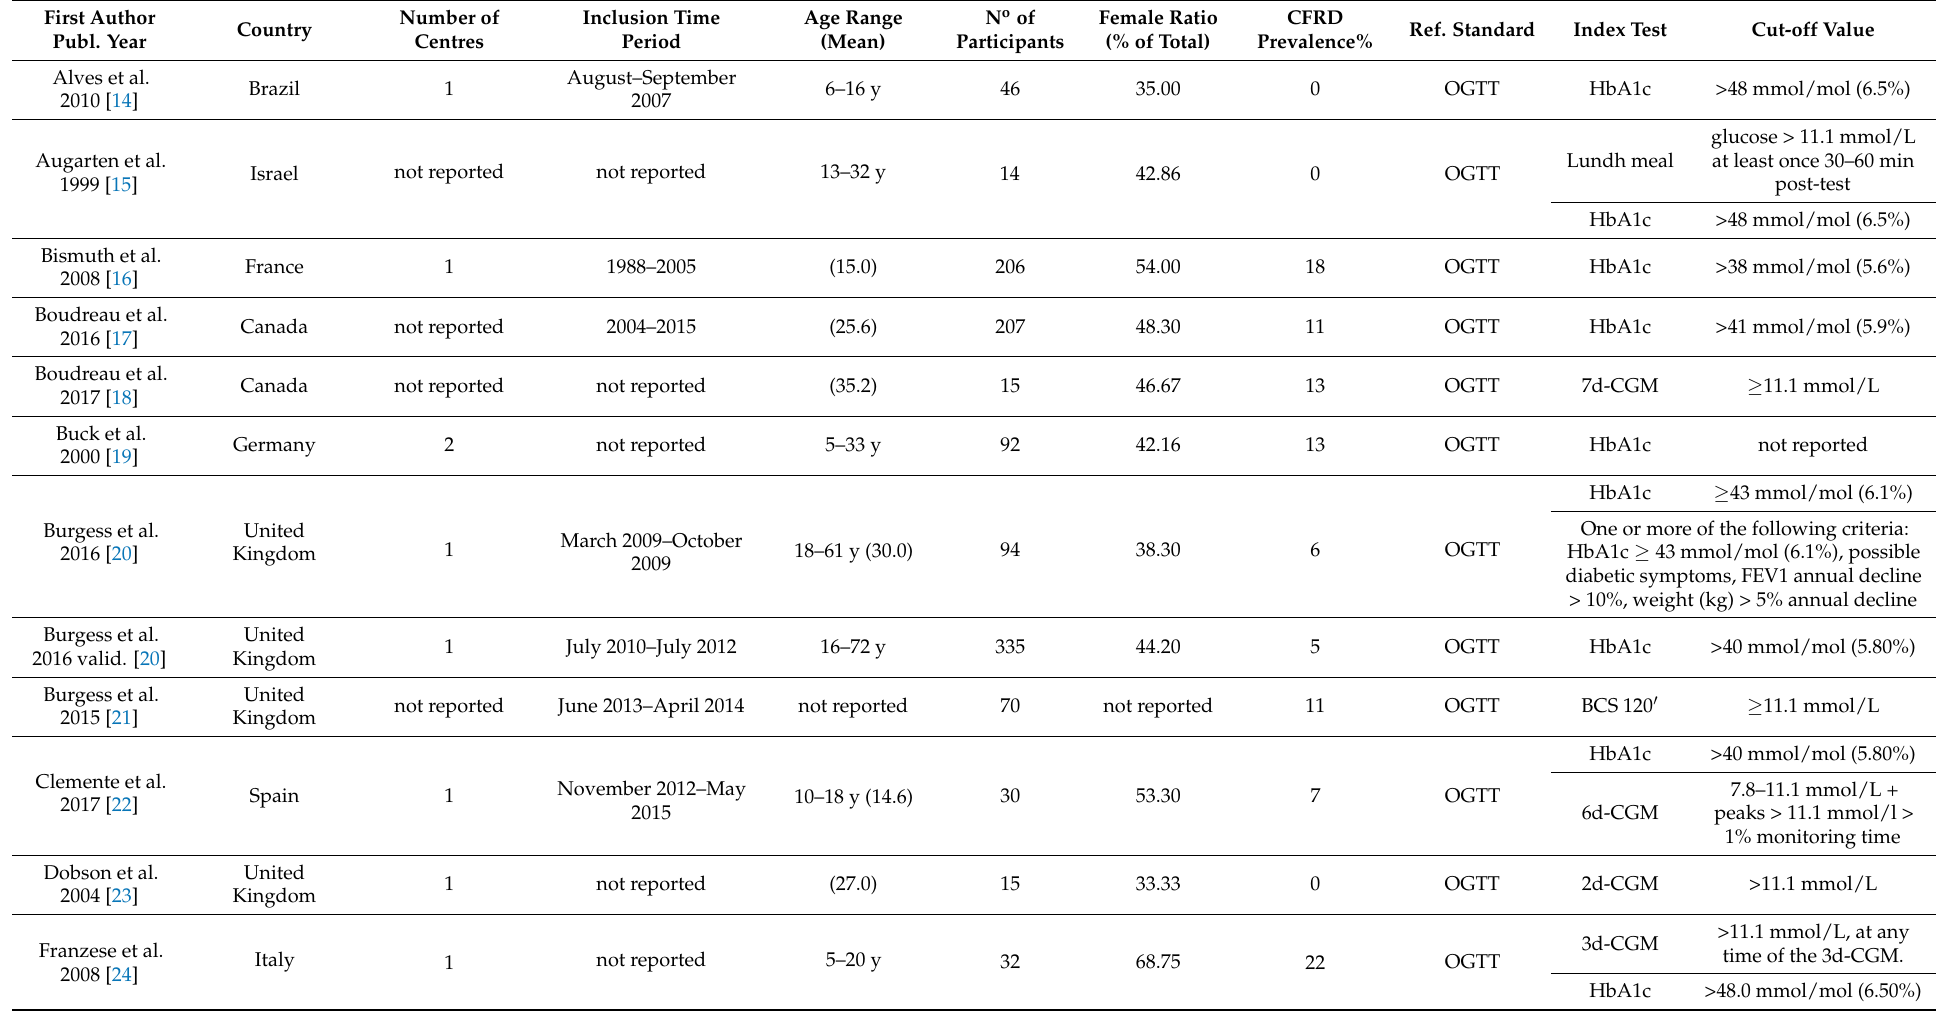
Table 1. Main characteristics of the studies included in the network